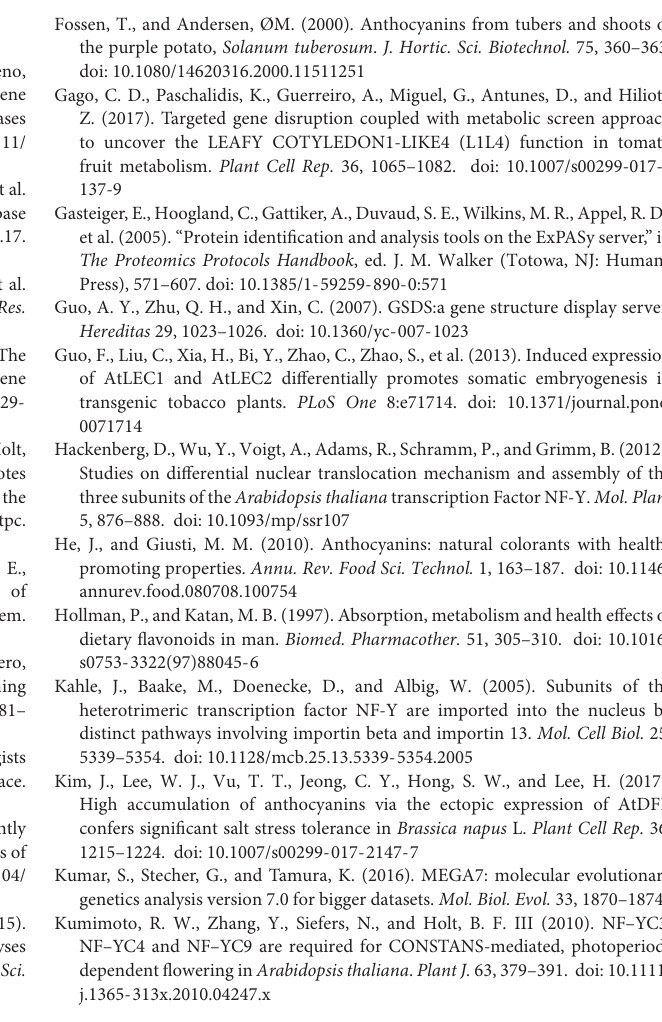
Supplementary Table 10 | Protein interaction network of StNF-Ys. Supplementary Table 11 | The FPKM value of genes in protein interaction